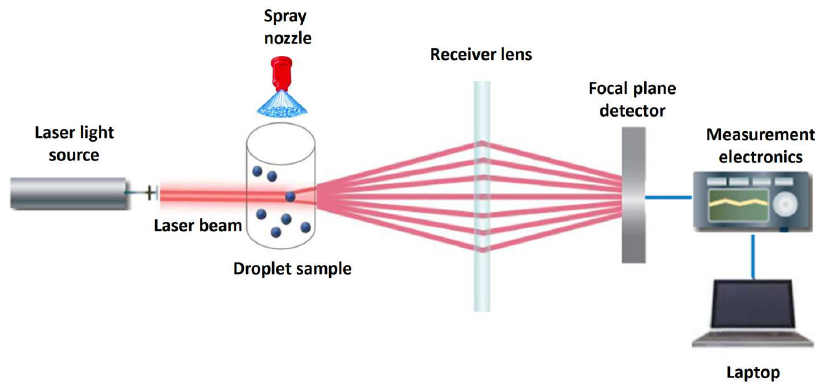
Figure 2. Scheme of the laser diffraction measurement system.